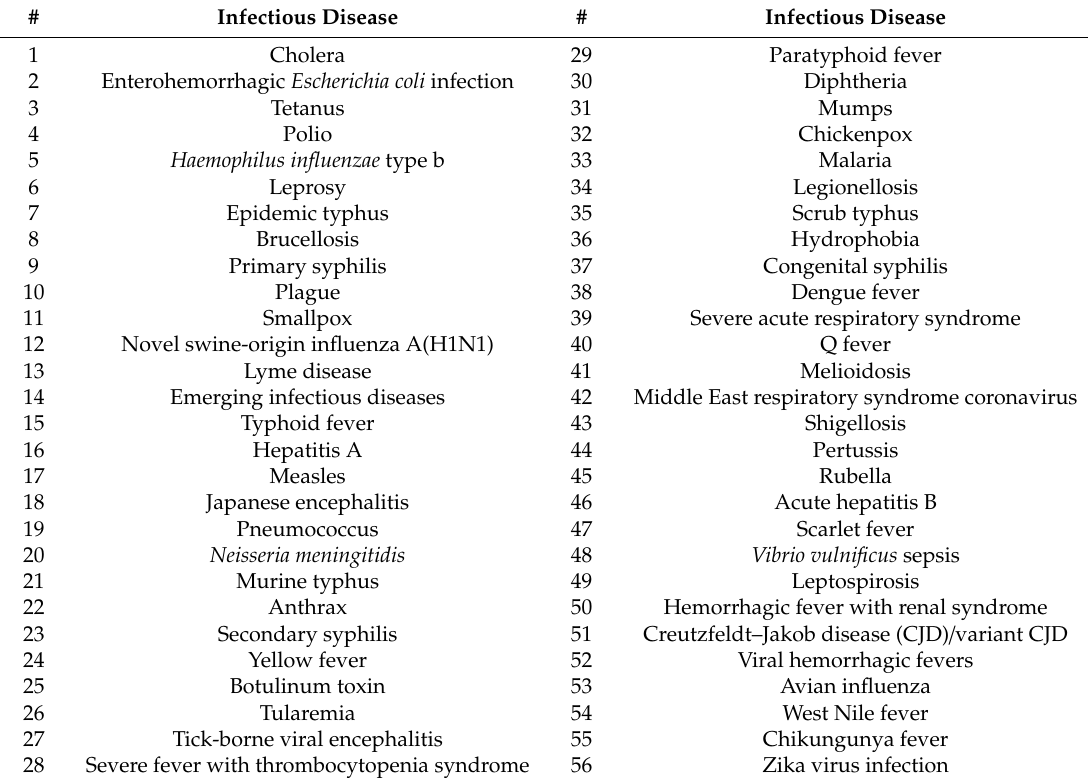
Figure 2. Disease occurrence data organized by date. Table 1. A list of infectious diseases.